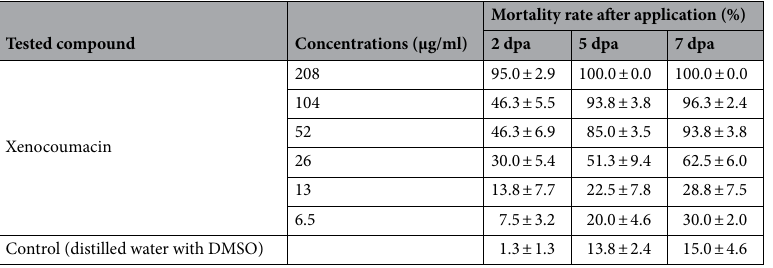
Table 2. Effect of different dilutions of extracted acaricidal compound (xenocoumacin) on Tetranychus urticae adult females (mean ± S.E.).